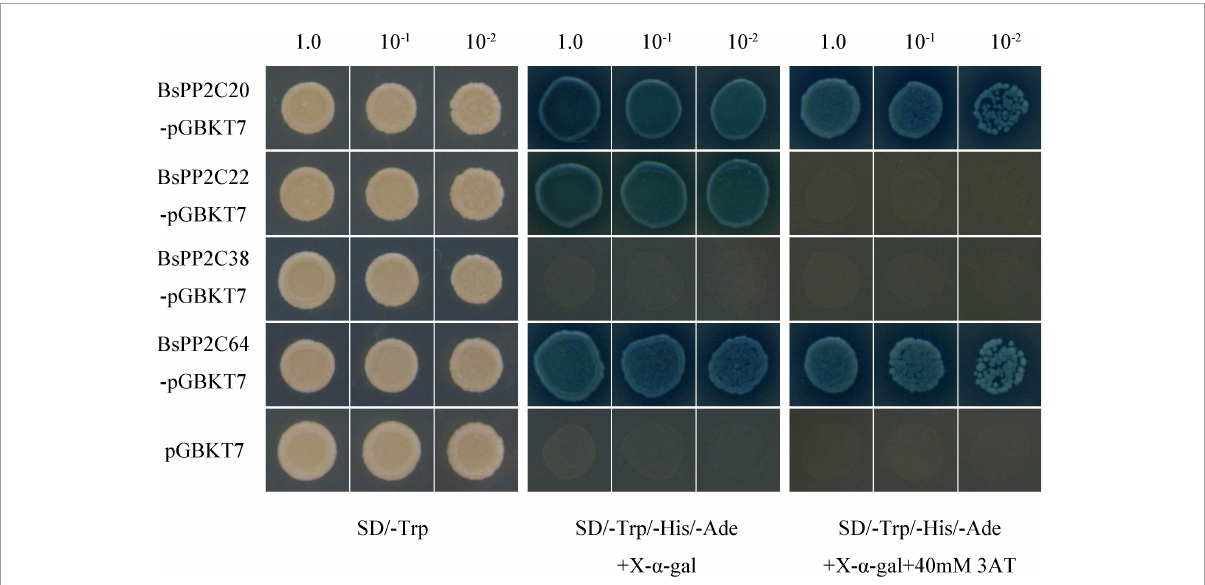
FIGURE7 Yeast Transactivation Activity Assay of BsPP2C20, BsPP2C22, BsPP2C38, and BsPP2C64. The BsPP2C20, BsPP2C22, BsPP2C38, and BsPP2C64 were fused with the DNA-binding domain (BD). BD-BsPP2C20 + AD, BD-BsPP2C22 + AD, BD-BsPP2C38 + AD, and BD-BsPP2C64 + AD, respectively, were grown on SD/-Trp media, SD/-Trp/-Ade/-His + X- α -gal, and SD/-Trp/-Ade/-His + X- α -gal + 40 µ M 3-AT media.